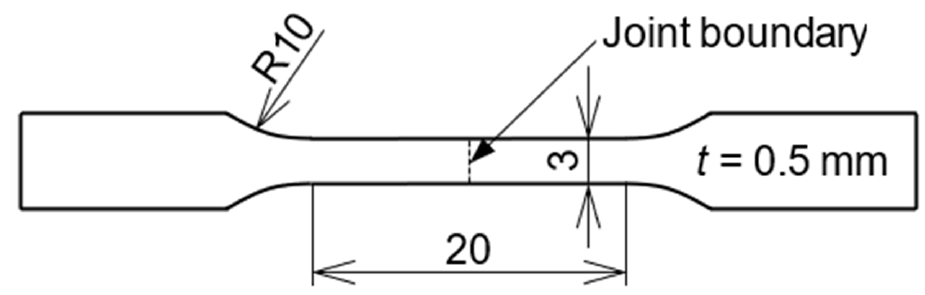
Figure 9. Schematic of tensile test specimen joined using sheared surface.